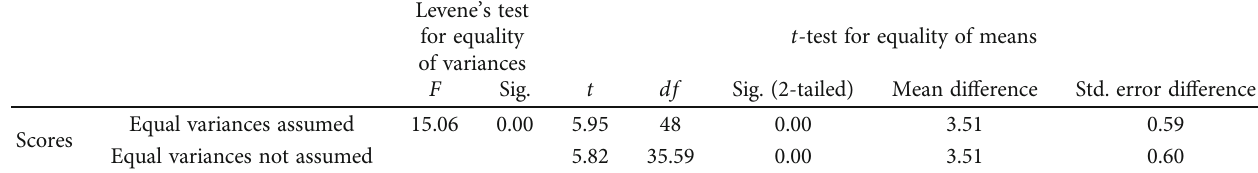
Table 4: Independent sample t -test (the posttest of both groups).